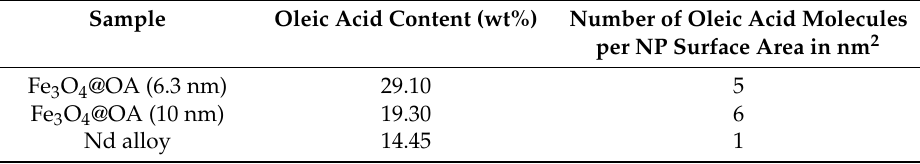
Table 1. Oleic acid content in each synthesized nanoparticle.